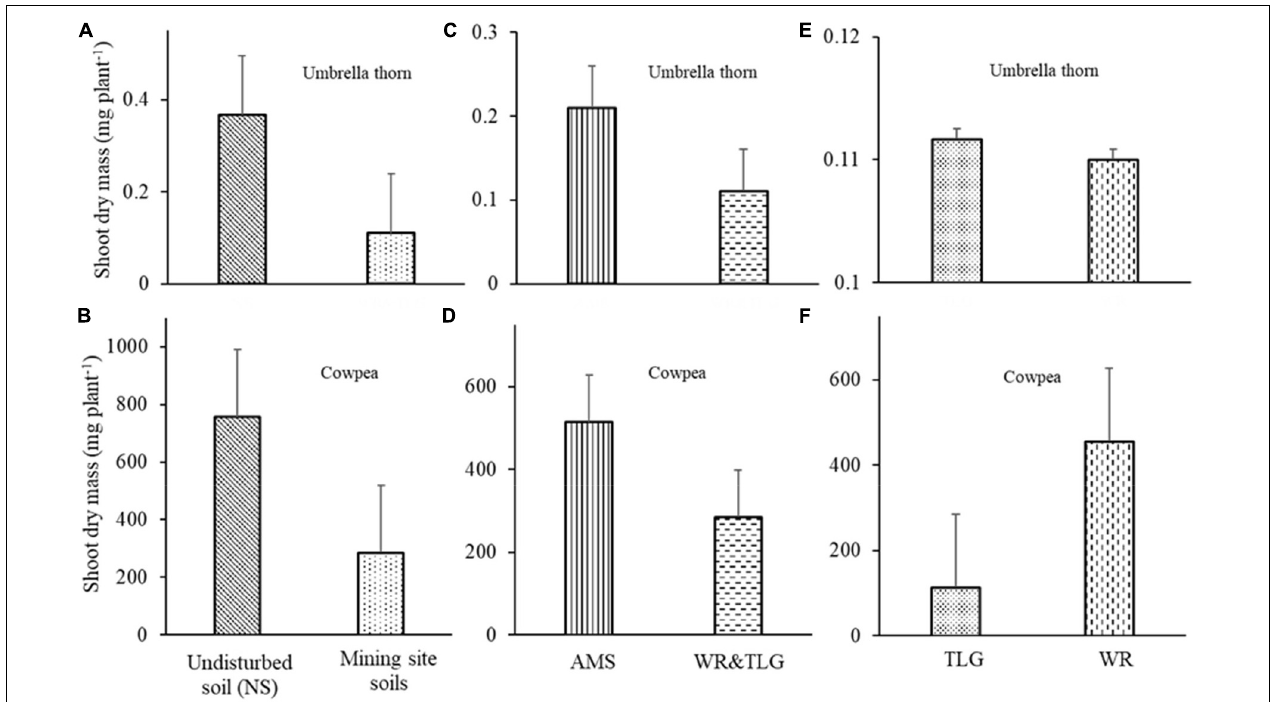
FIGURE 3 | Umbrella thorn (A,C,E) and cowpea (B,D,F) shoot dry-mass responses to contrasting soil types in the greenhouse: undisturbed-natural soil (NS) vs mine site soils (A,B) ; soils of the artisanal mining site (AMS) vs soils of the conventional mining site (C,D) ; and Mine tailings (TLG) vs waste rock stockpile (WR) (E,F) . Error bars represent the standard errors of